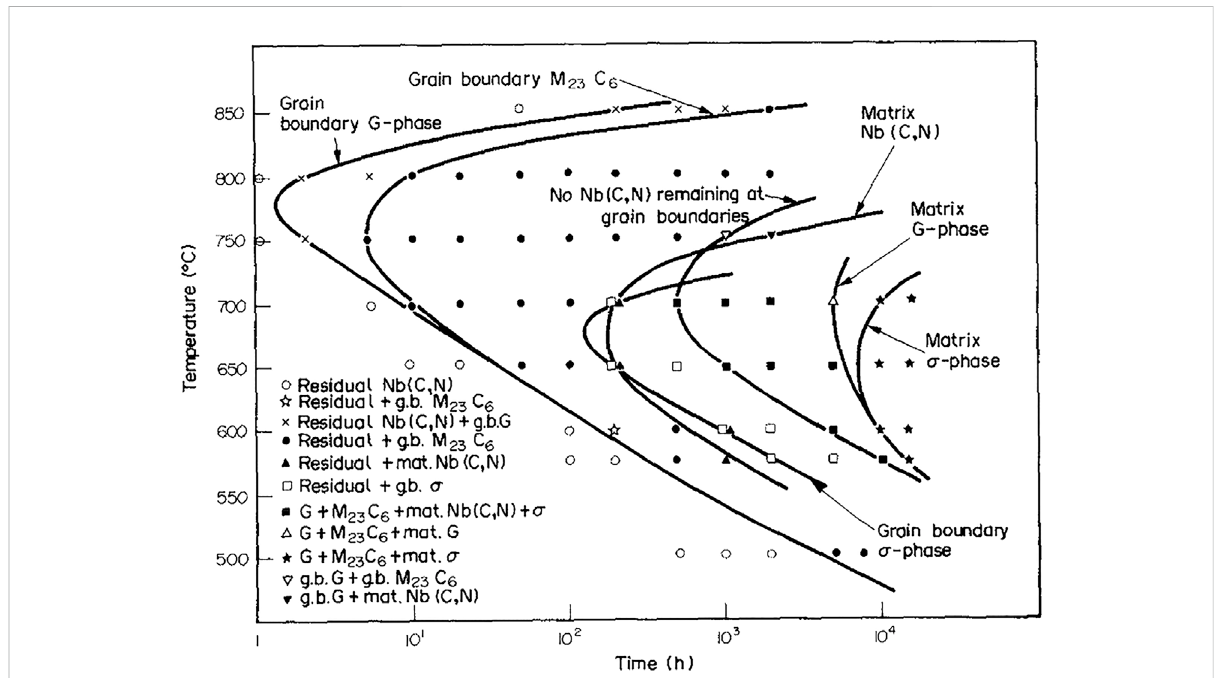
FIGURE 1 TTP (time-temperature-precipitation) diagram of aging process of 20Cr25NiNb at 500 ° C – 850 ° C (Powell et al.,